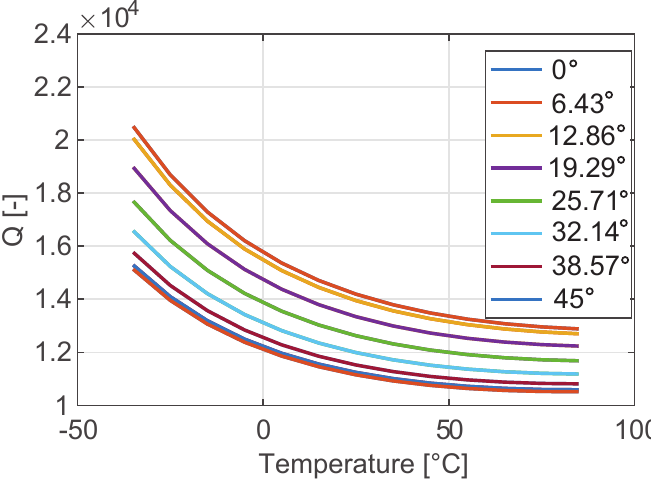
Figure 6. Temperature variation of the quality factor of the tuning fork in the range [ − 35 ◦ C–85 ◦ C] for different orientations ϑ of the device with respect to the silicon